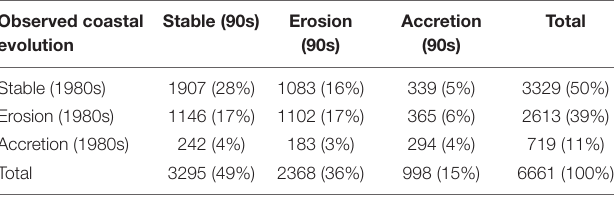
TABLE 1 | Frequency matrix of transitions between CEC and Eurosion coastal site evolution features. Observed coastal evolution